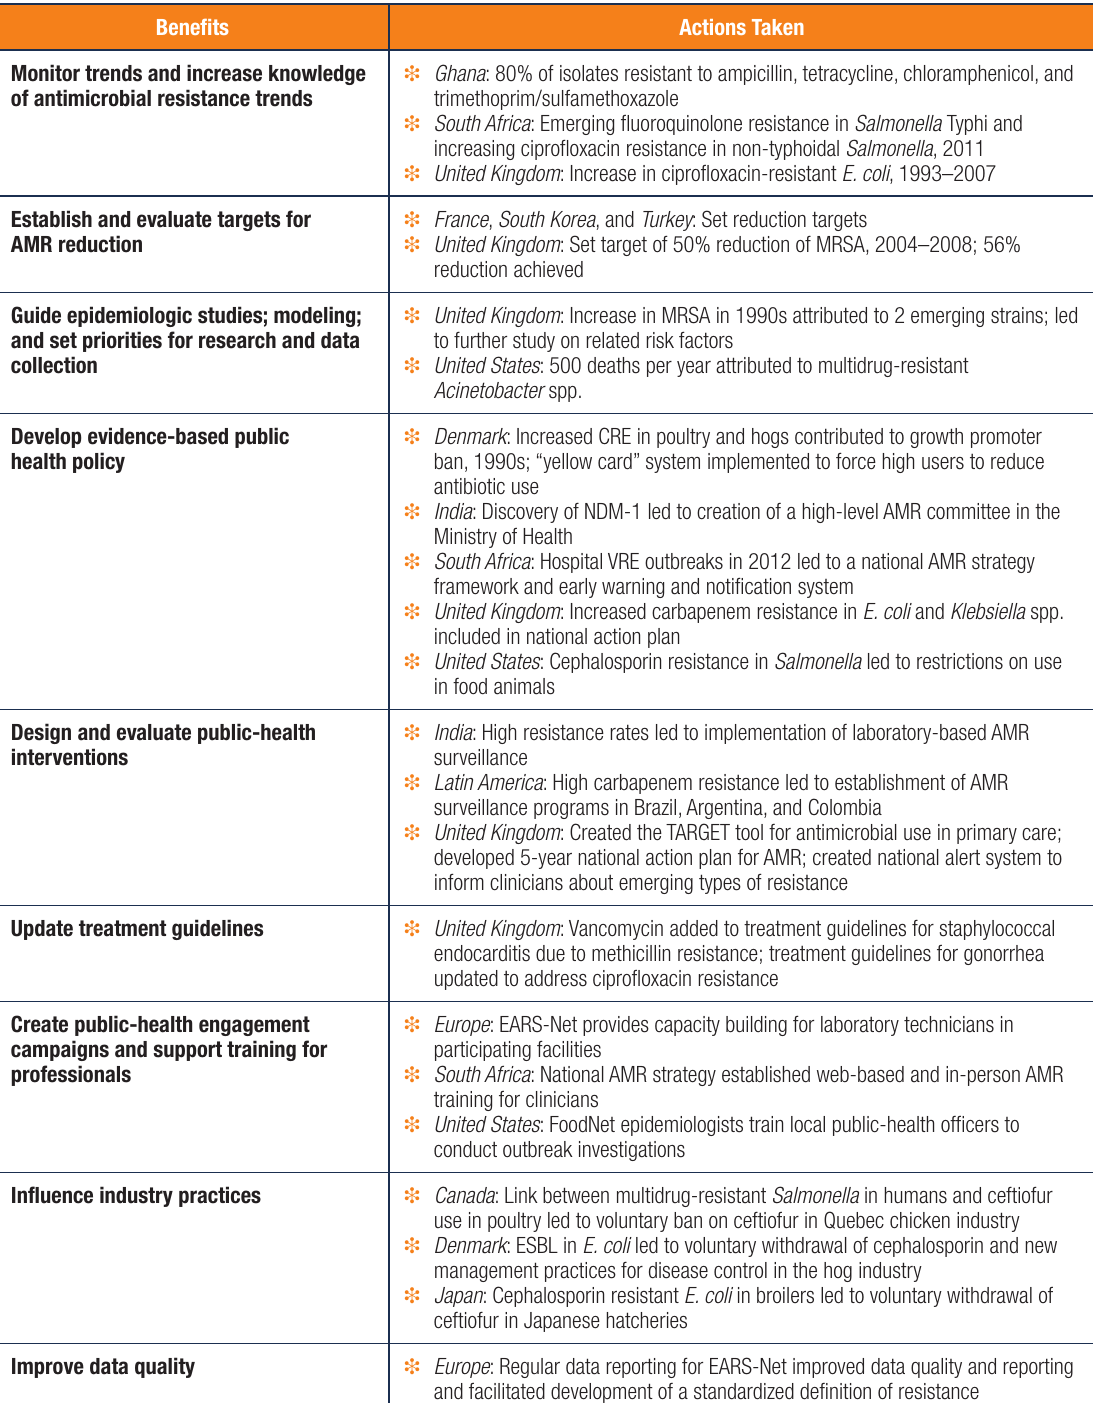
TABLE 4. Specific Examples of Benefits of AMR